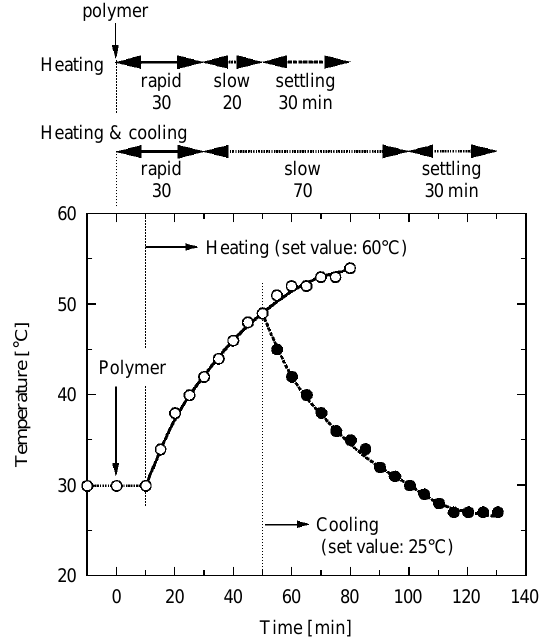
Polymer dosage [kg/kg-kaolin] Fig. 3 Flocculation performance above and below the transition temperature (about